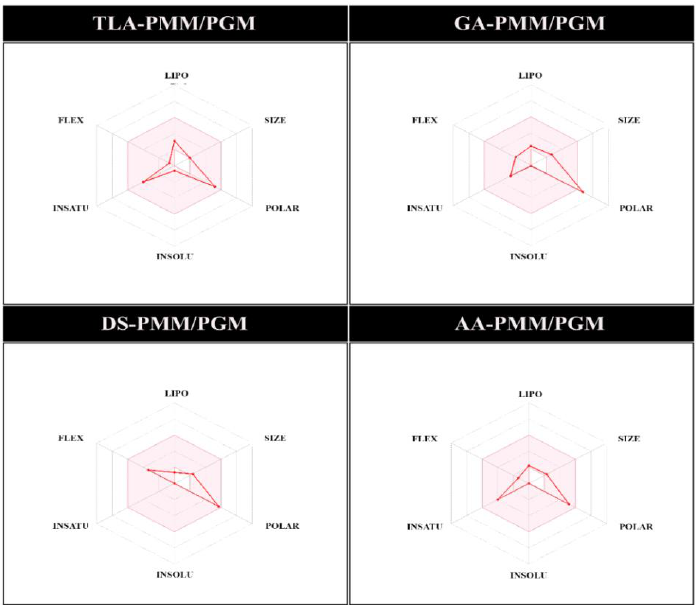
Figure 7. Prediction of the oral bioavailability of the phosphomannomutase/phosphoglucomutase inhibitor.